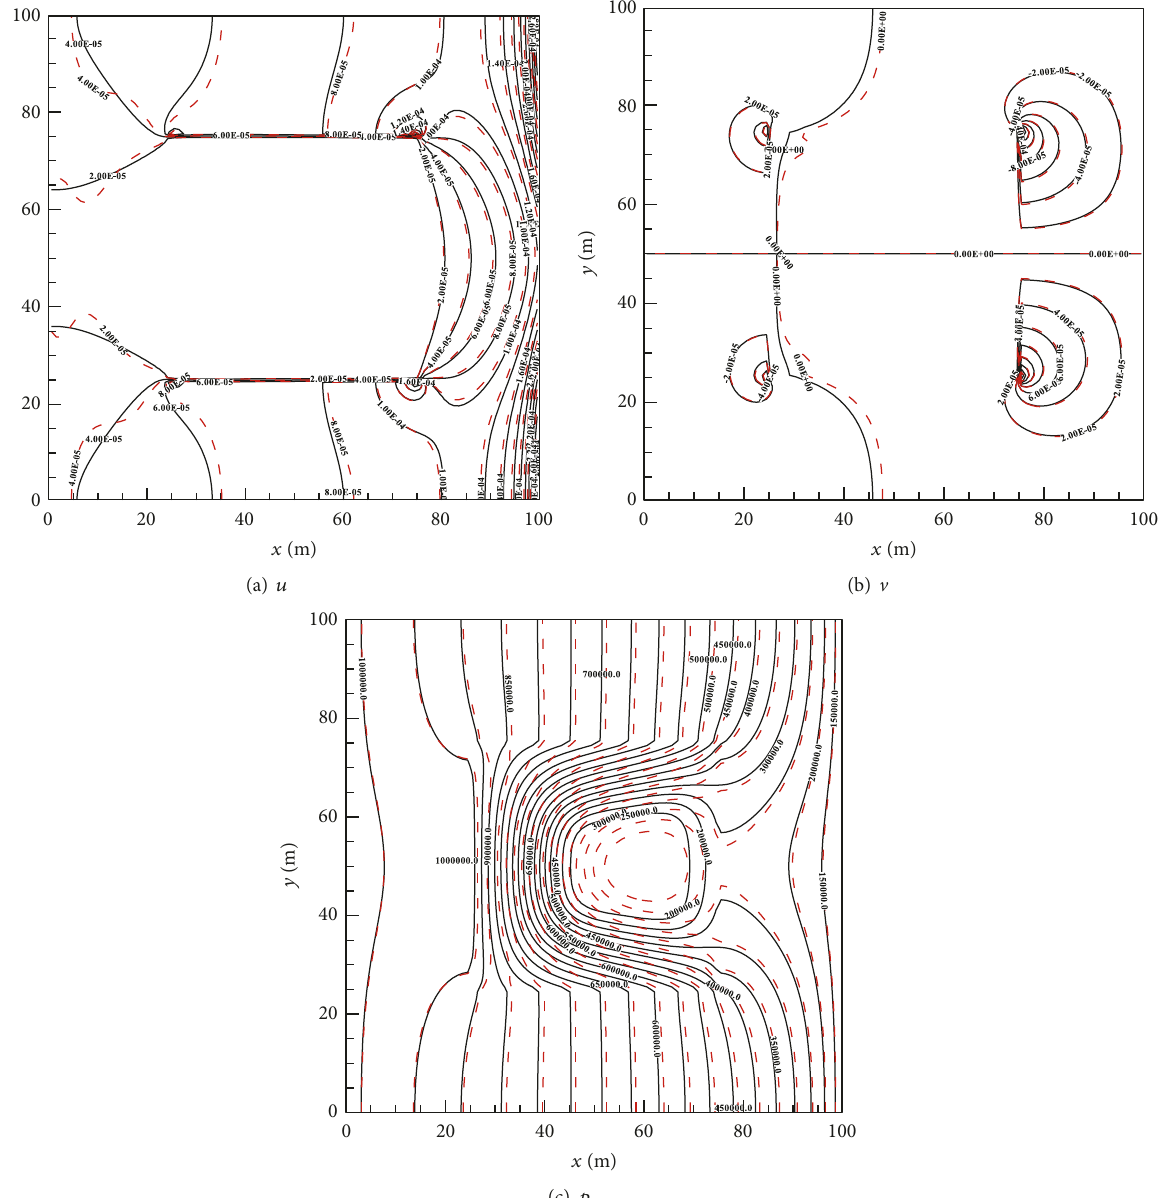
Figure 6: Flow field comparison for the mean deviation. Black line: FDM; red dashed line: